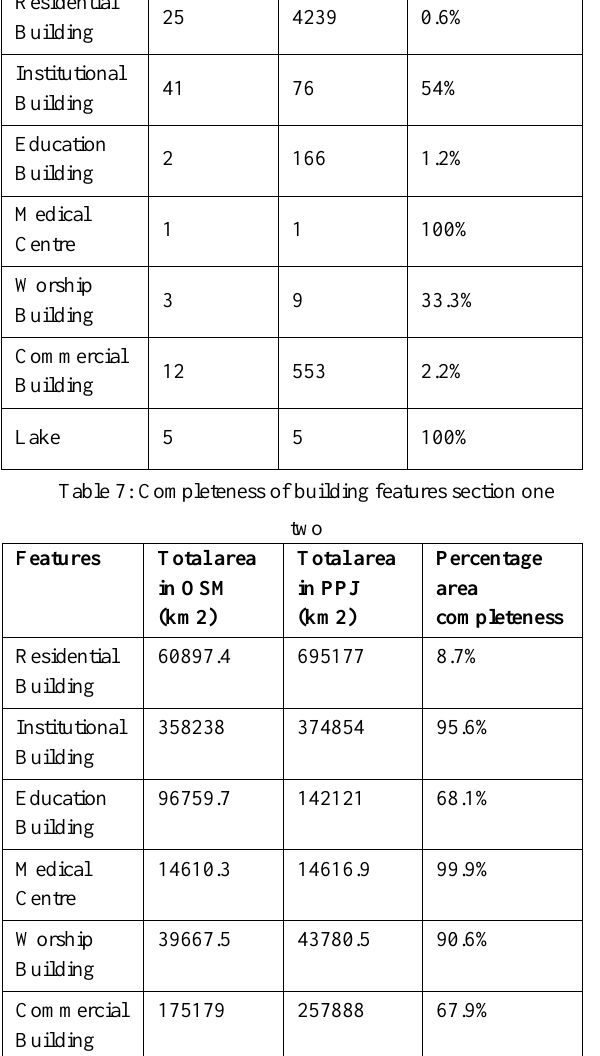
Table 10: A sample of incorrect road names for OSM dataset Overall, the percentage of building features with correct attributes was 28%. This shows that more than half of the attributed „name‟ fields were blank. Most of the attributes were left blank and only a few were mismatched with the PPJ dataset. Based on Table 11, residential buildings showed zero percentage as most of the residential buildings were left blank whereas a few of them were incorrectly